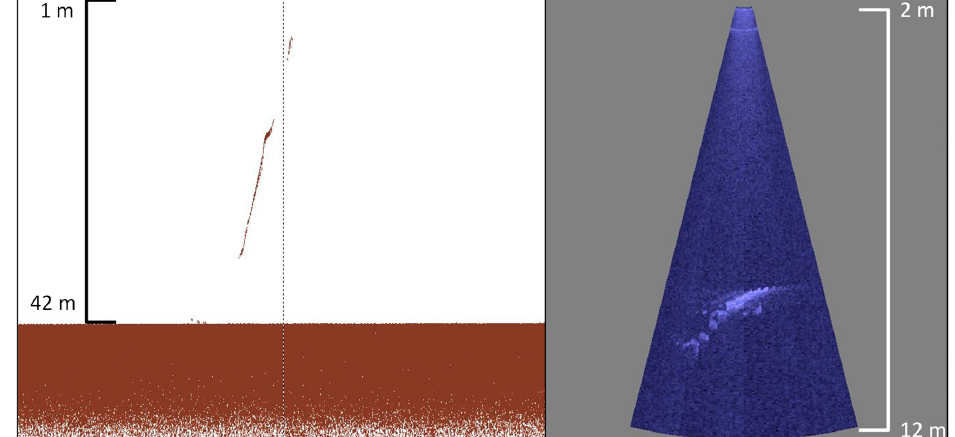
Figure 5. Simultaneous views of a porpoise collected with the Simrad single beam echosounder and the DIDSON acoustic camera. Simrad TS data are shown in the echogram on the left, which has a − 30 dB re 1 m 2 threshold applied. A DIDSON data frame is on right, has no threshold applied, and corresponds in time to vertical dashed line in the Simrad echogram. Time on the Simrad single beam echosounder is from left to right. Time on the DIDSON is frame by frame like a video. See supplementary file for video.